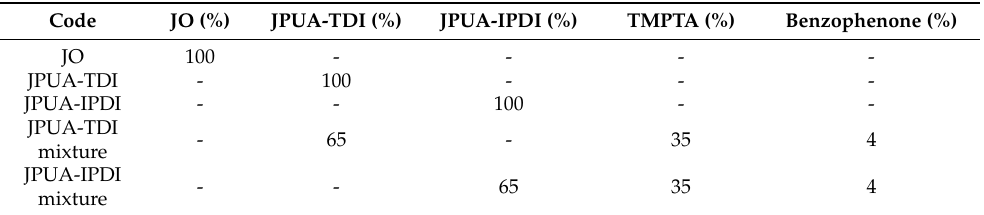
Table 2. Components of JO, JPUA-TDI and JPUA-IPDI-based mixture